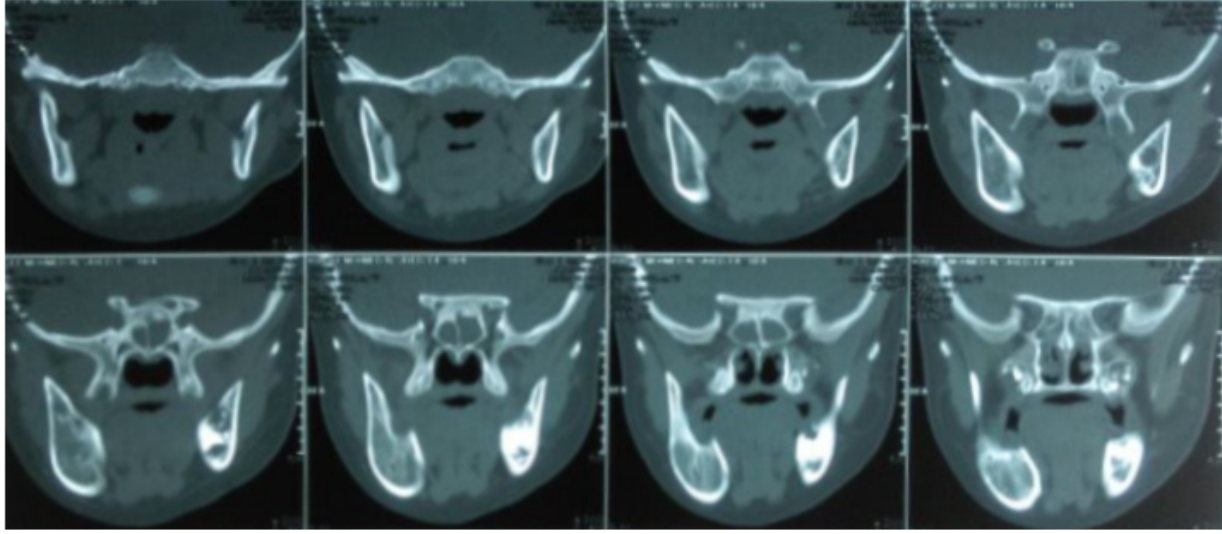
Figure 3. Follow up Computerized tomography scan revealed a new spongy bone formation at the site of preexisting lesion.